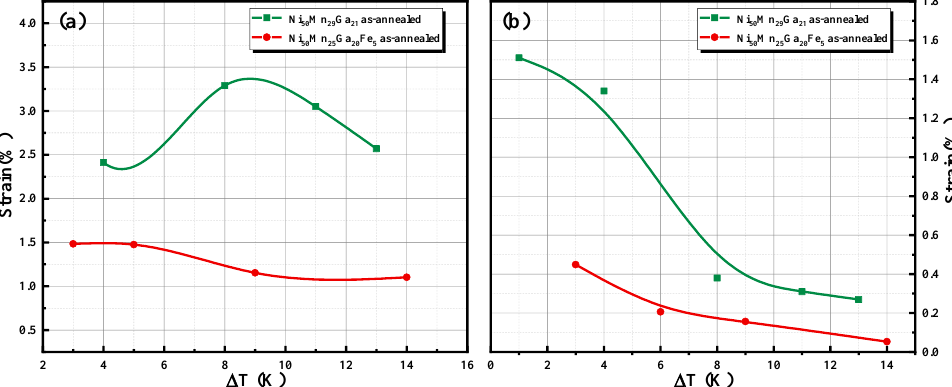
Figure 6. ( a )Total microwire strain-temperature difference curve, ( b )microwire residual strain-tem- Figure 6. ( a ) Total microwire strain-temperature difference curve, ( b ) microwire residual strain- perature difference curve. temperature difference